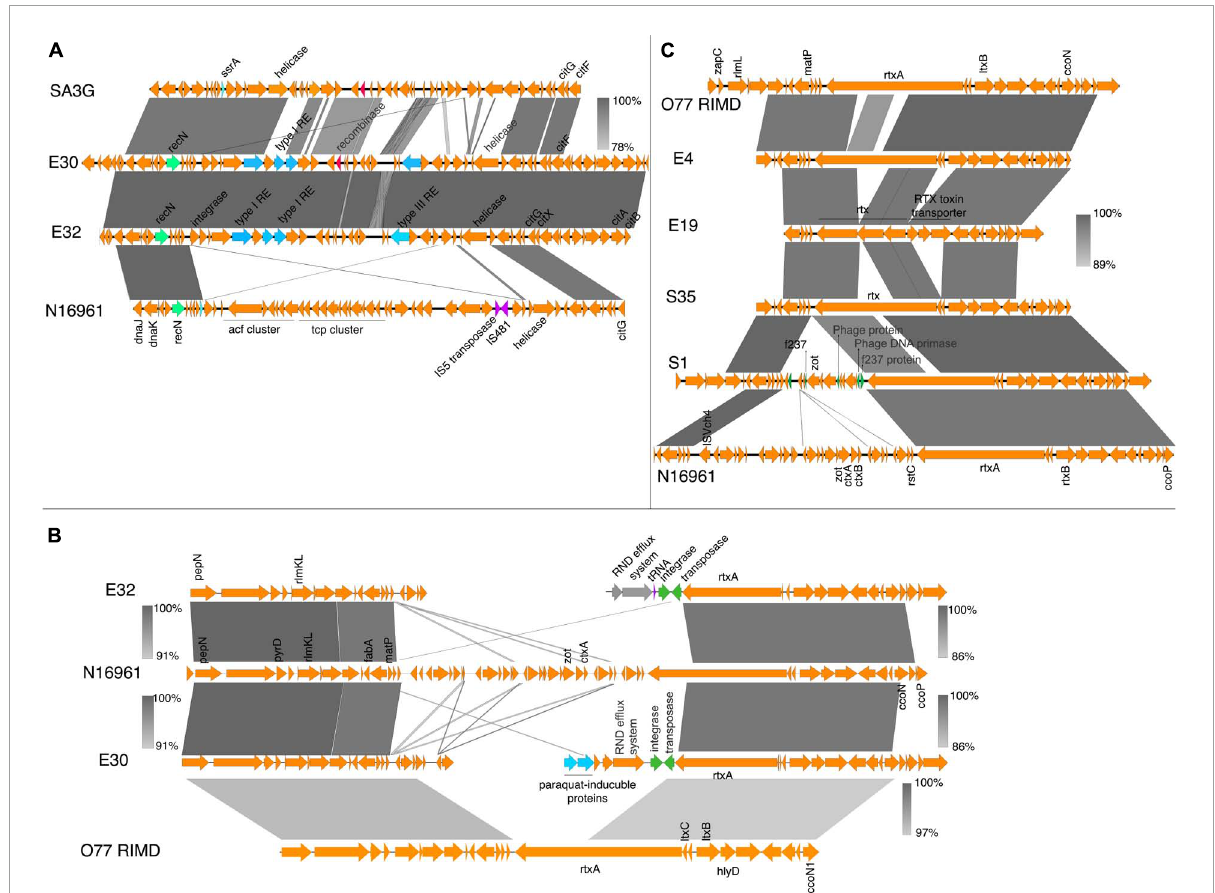
FIGURE2 Virulence genes in V. cholerae isolates. (A) Schematic gene organization and alignments of the region containing the acf and tcp gene clusters in the N16961, SA3G, and the environmental isolates E30 and E32. The E30 and E32 share high similarities (between 93 and 100%) in gene organization around the location containing the virulence gene clusters in the reference strain. (B) Gene organization and alignment of the zot, ctxAB region in N16961, SA3G and the environmental isolates E30 and E32. (C) The gene order and alignment of the zot and ctx gene clusters in E4, E19, S35, S1, N16961, and O77 RIMD. The absence of the zot and ctx genes and disruption in synteny around the genomic regions is observed in the E30 and E32 isolates. The decay in the gene order in the zot and ctx region compared to the reference strain is shown